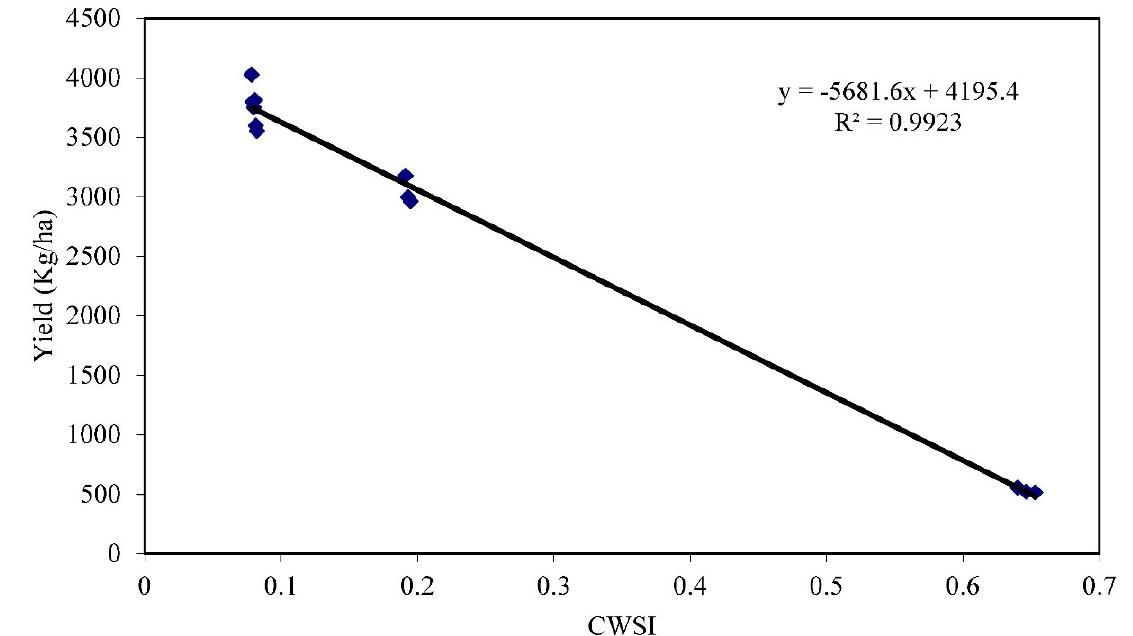
Figure 7. Relationship between yields of wheat crops related to seasonal CWSI.